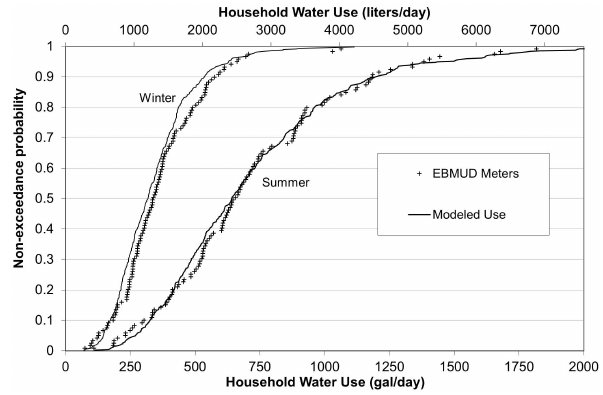
Fig. 2. Calibration of existing conditions modeled use to metered seasonal use.